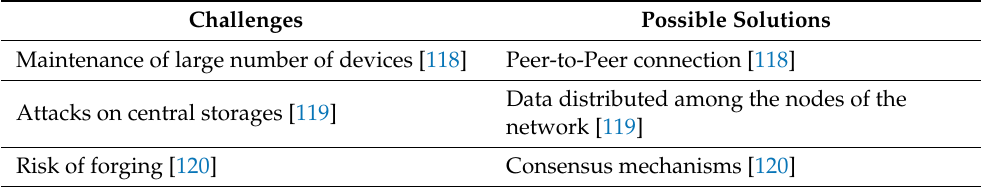
Table 3. Blockchain for IoT.